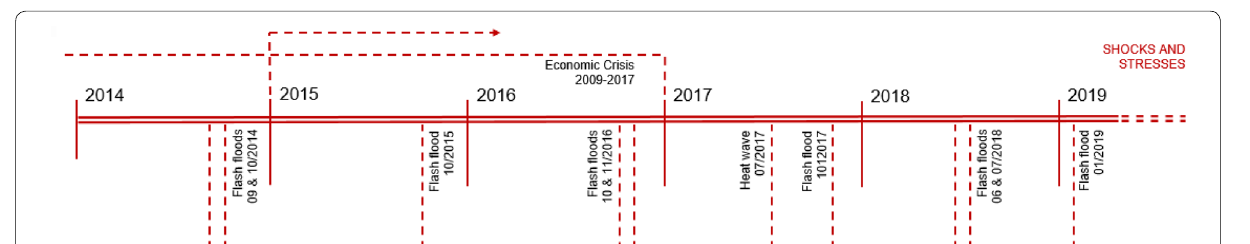
Fig. 2 Occurred shocks and stresses in Athens Source: Resilient Athens (2017); meteo.gr;